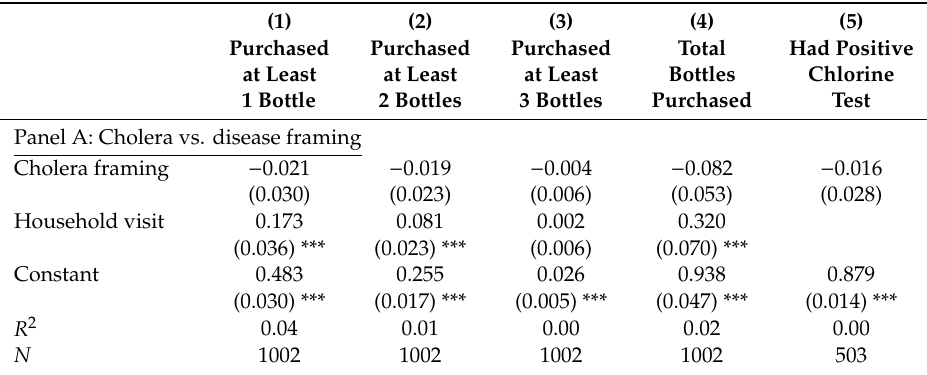
Table 6. Impact of message